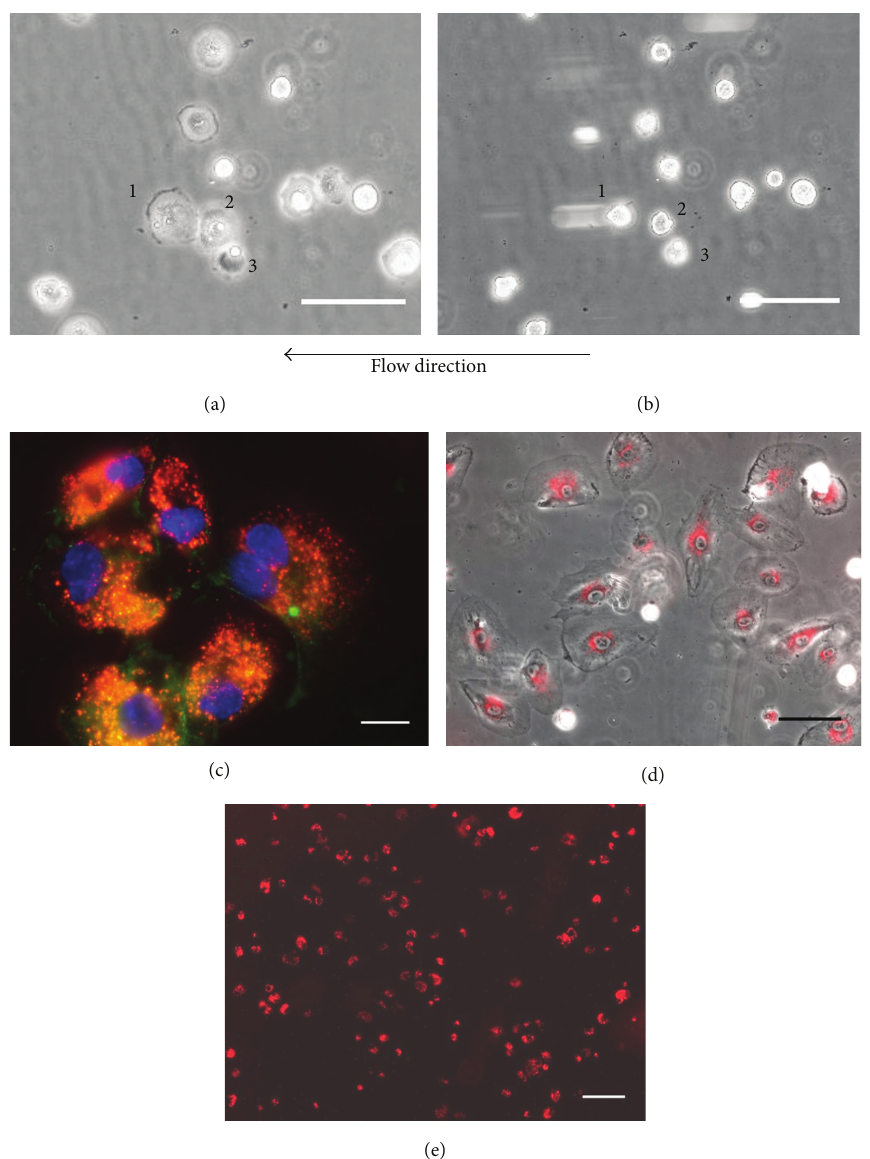
Figure 6: LO-EPC (4 × 10 5 ) were perfused over fibronectin-coated Ibidi slides and time lapse imaging was used to visualise and record LO- EPC adhesion. Representative still images show three adherent cells after initial capture (a, b) after 4 min of perfusion (0.7 dyn/cm 2 ). Scale bar represents 30 𝜇 m. Adherent LO-EPC form lateral adhesion junction (c). LO-EPC labelled with DiI-Ac-LDL shown red and VE-Cadherin expression shown green. Scale bar 20 𝜇 m. 24 hours after adhesion to fibronectin, LO-EPC spread and proliferate (d). Scale bar represents 60 𝜇 m. The adherent LO-EPC effectively cover a fibronectin-coated surface (e). Scale bar represents 110 𝜇